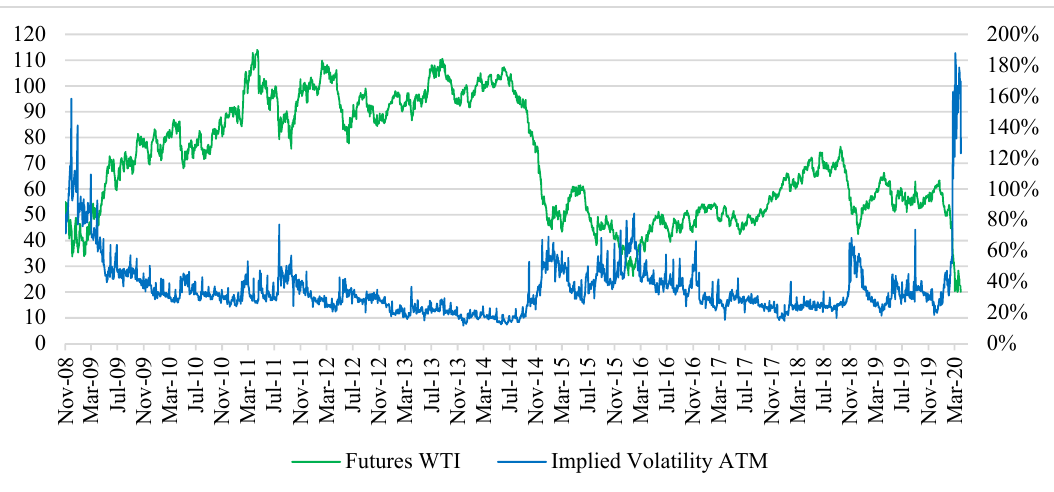
Figure 2. Plots of raw data. The left axis denotes the West Texas Intermediate (WTI) crude oil prices (front-month futures), while the right axis denotes the implied volatilities of at the money (ATM) options.